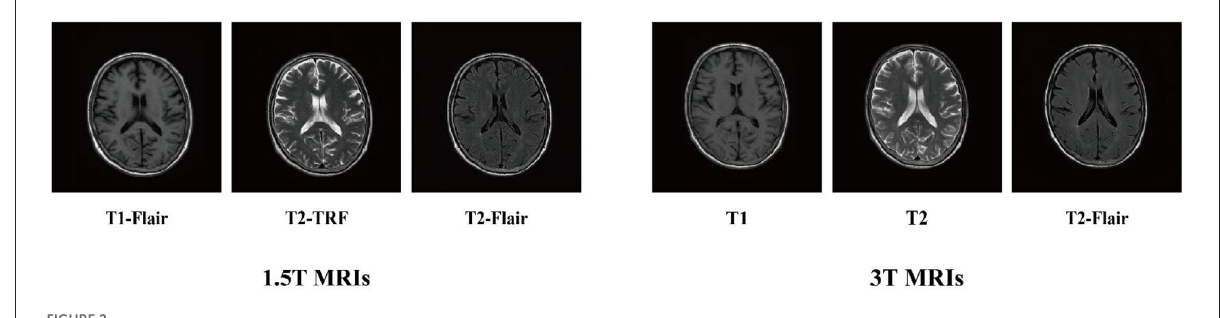
FIGURE2 1.5T MRIs and 3T